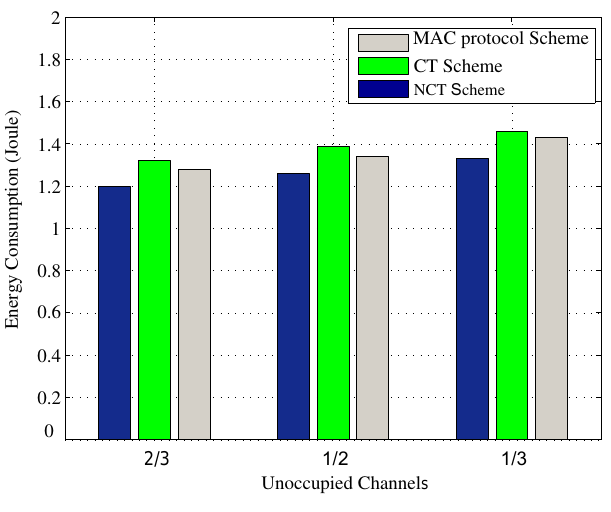
Fig. 5: Comparison of Different Schemes in Terms of Energy Consumption for (cid:17) = 0.6 MAC Protocol Scheme CT S cheme0.5